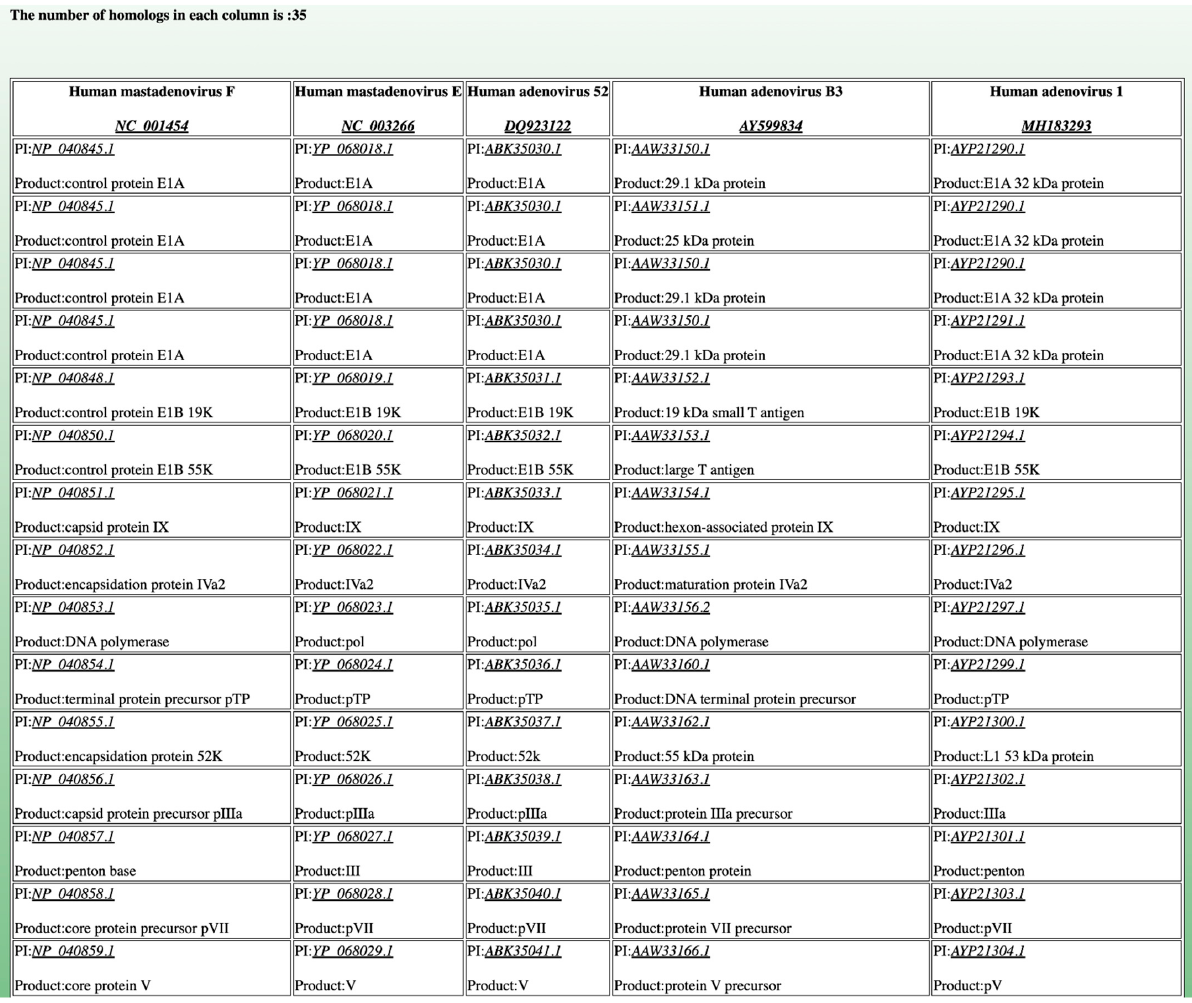
Figure 2. Partial CoreGenes output from five human adenovirus genomes. The total number of core genes found is 35. Links to the complete genomes and individual proteins are also provided for additional analysis. Table 2. CoreGenes5.0 analysis of three bacterial genomes. Five runs were completed, with different but uniform genome sizes for each run. The data were processed using the Bidirectional Best Hit method, paralog inclusion, and an e-value of 1 × 10 − 5 .